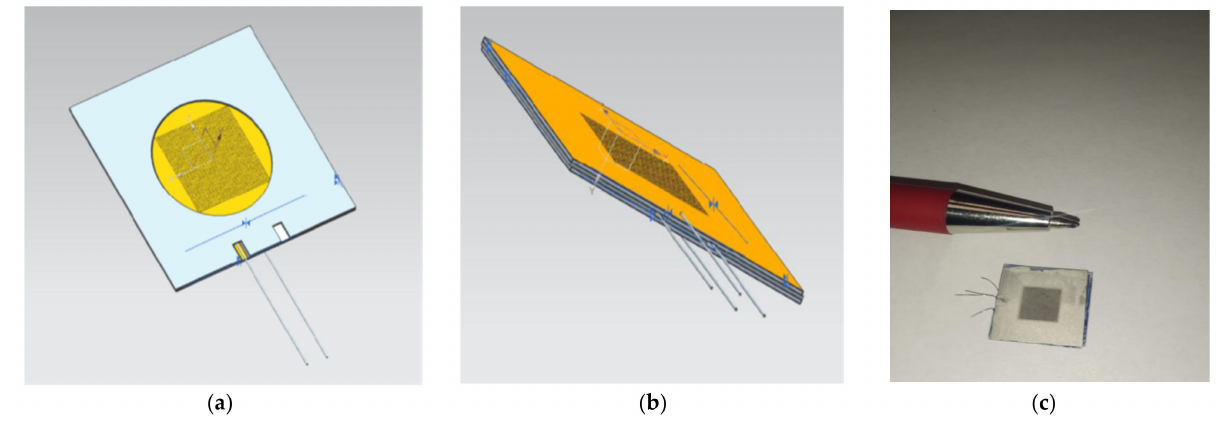
Figure 3. The conversion element design ( a ) partially assembled element—outer plate with a dividing plate; ( b ) a schematic view of the package assembly; ( c ) the conversion element.